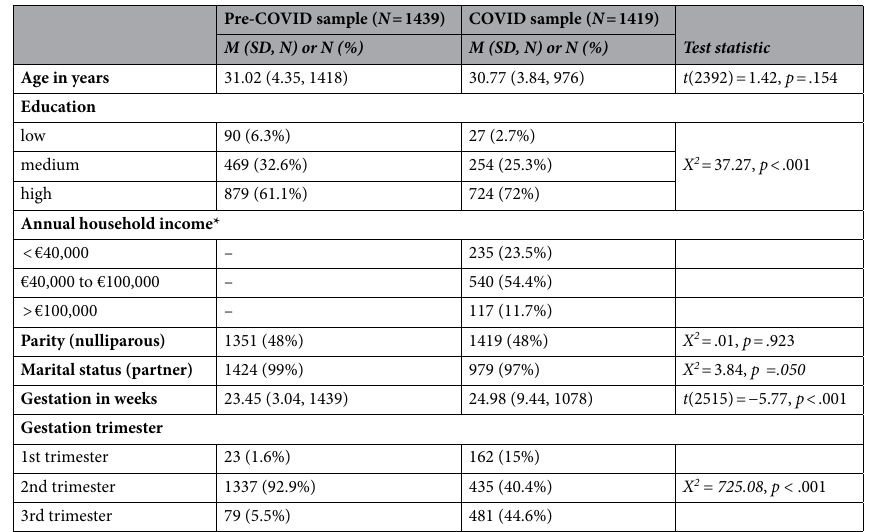
Table 1. Demographic characteristics of the samples. M = mean, SD = standard deviation, t = t-test, X 2 = Chi- square, p = significance level set at < .05. Income information was not available in the pre-COVID sample. Education = low: primary education or secondary pre-vocational education, medium: secondary education or vocational education, high: Bachelor or Master’s degree or higher (i.e. PhD). *11% of respondents in the COVID sample indicated that they preferred not to answer the question on annual household